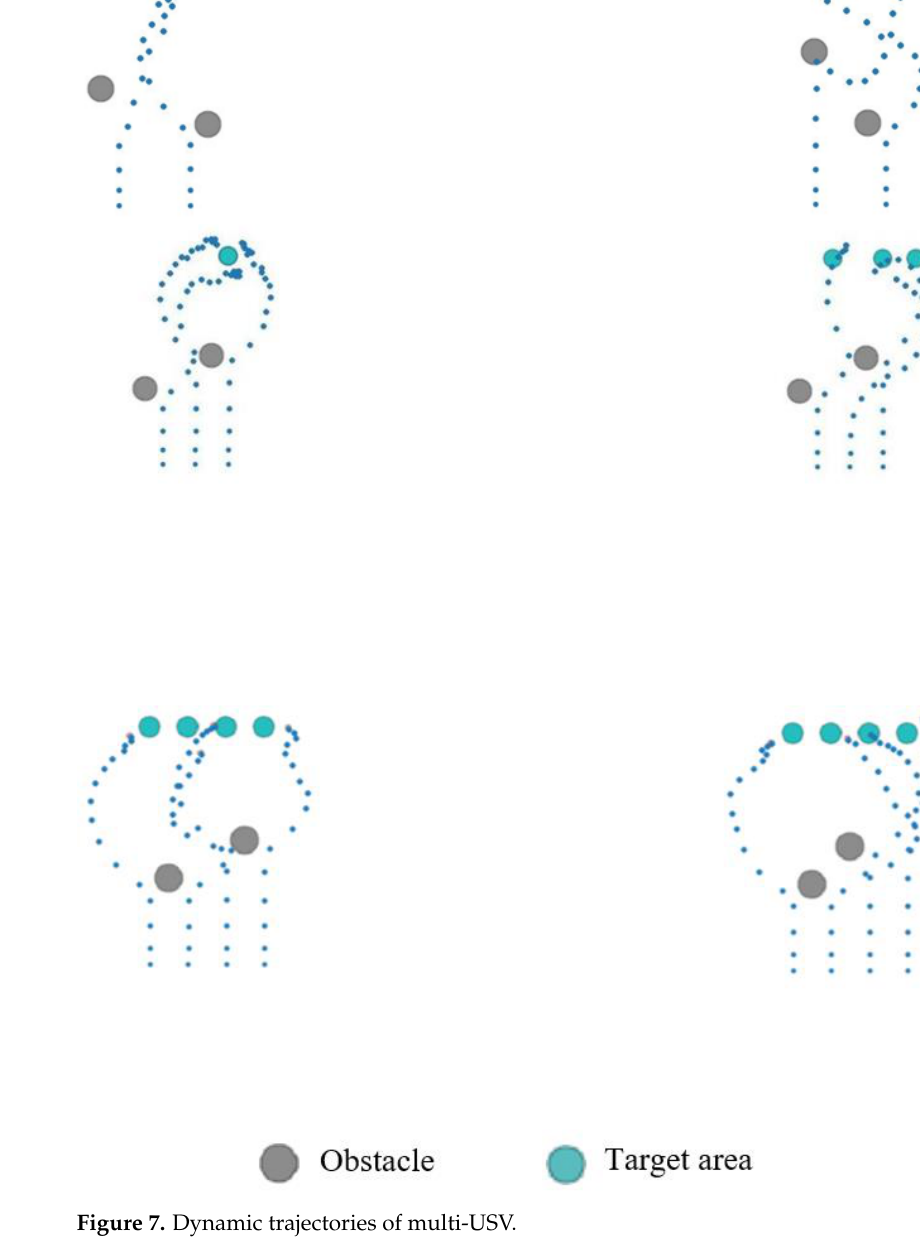
Figure 7. Dynamic trajectories of multi-USV.